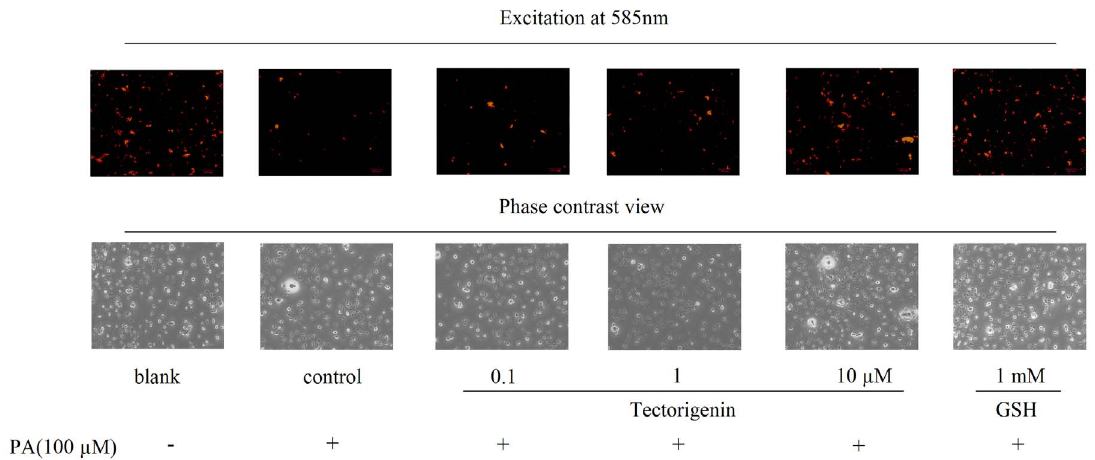
Figure 2. Tectorigenin reversed PA-induced collapse of mitochondrial membrane potential ( Dy m) in HUVECs. Cells were pretreated with tectorigenin (0.1, 1, 10 m M) or GSH for 30 min, and then stimulated without or with PA (100 m M) for an additional 30 min. The blank was treated with an equal amount of the vehicle (medium containing 0.1% DMSO and 10% BSA). Fluorescence images were shown by using a fluorescence microscope, and the intensity of red fluorescence is used to assess Dy m.